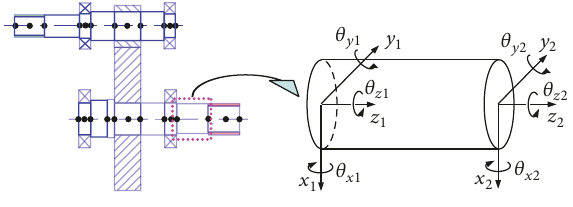
Figure 4: Model of the shaft